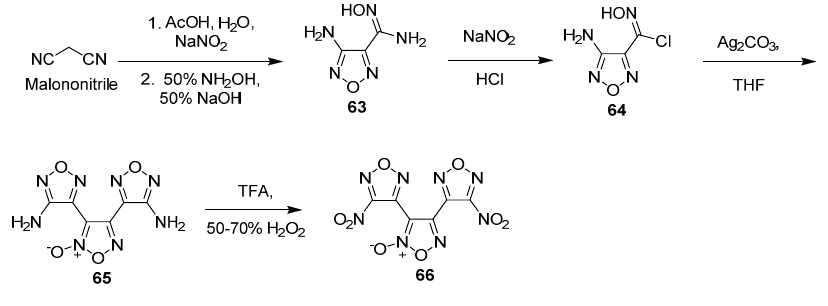
Table 8. Performance and sensitivities of tetranitrate ester 62.